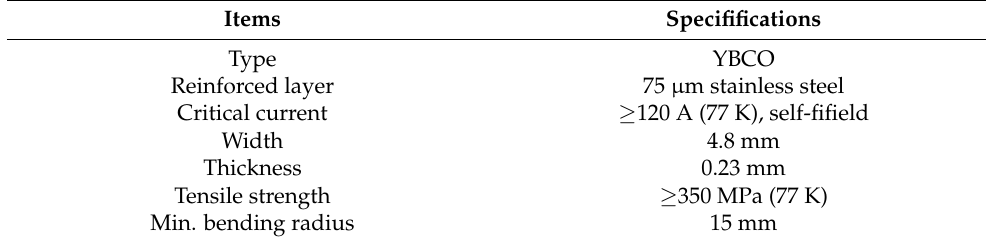
Table 2. Specifications of the HTS